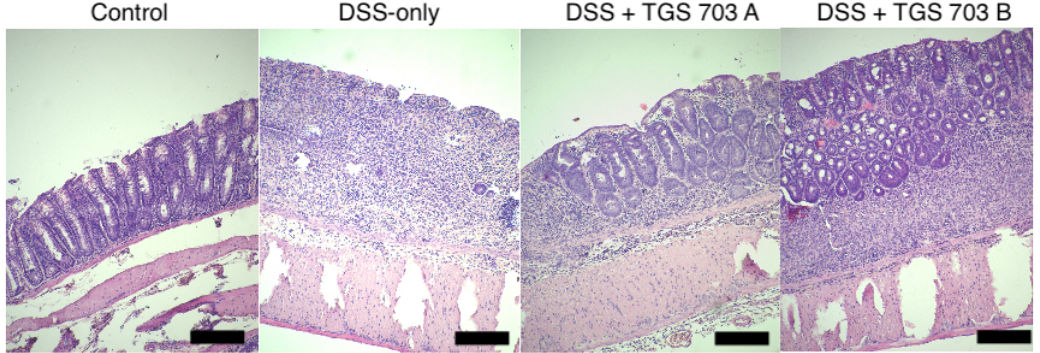
Figure 9. Representative photos of hematoxylin and eosin staining of colon samples. Scale bar = 100 µ m.